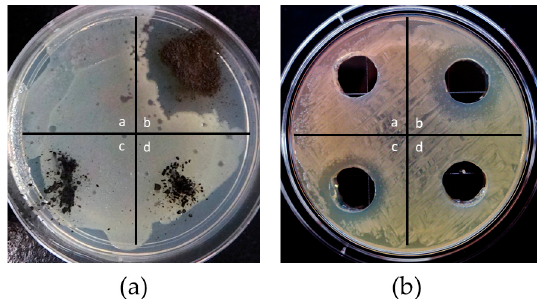
Figure 3. Antimicrobial activity of relevant MACAg components against E. coli . ( a ) Solid samples containing 0.25 mmol atoms of AgNPs in space b , MNPs in space c , and AC in space d were placed on an agar plate covered with 100 μ L of E. coli suspension of 2 × 10 8 CFU/mL (control is in space a ); ( b ) 100 μ L of liquid samples containing 2.5 × 10 − 5 mmol of Allura Red 40 ions in space a , Ag + ions in space b , Ag atoms in AgNPs (10 nm) in space c , and BH 4 − ions in space d were placed in the holes bored in an agar plate covered with 100 μ L of E. coli suspension of 0.5 × 10 8 CFU/mL. Only AgNPs